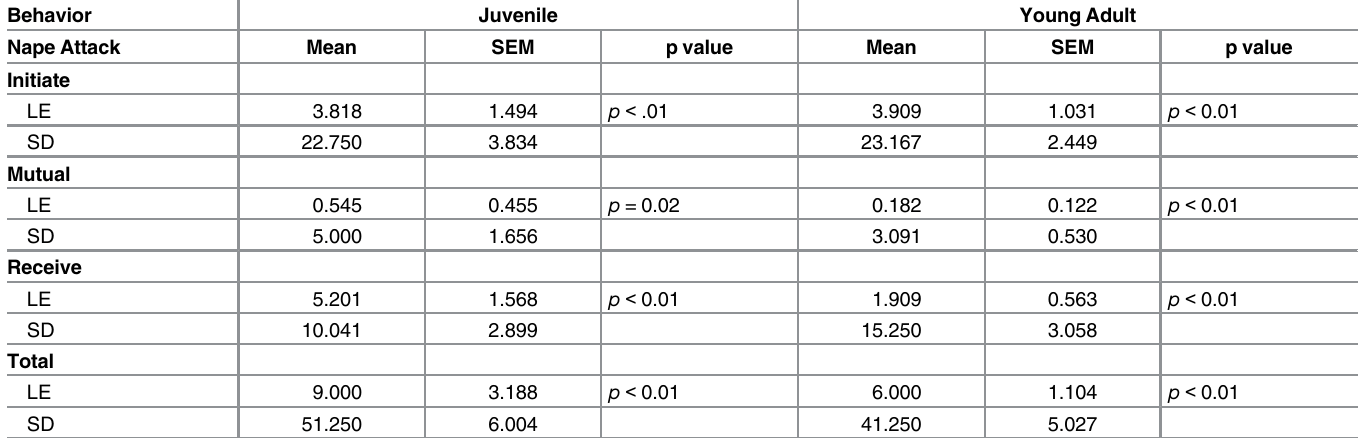
Table 4. Social Dyads at Juvenile and Young Adult time points — Frequency of Nape